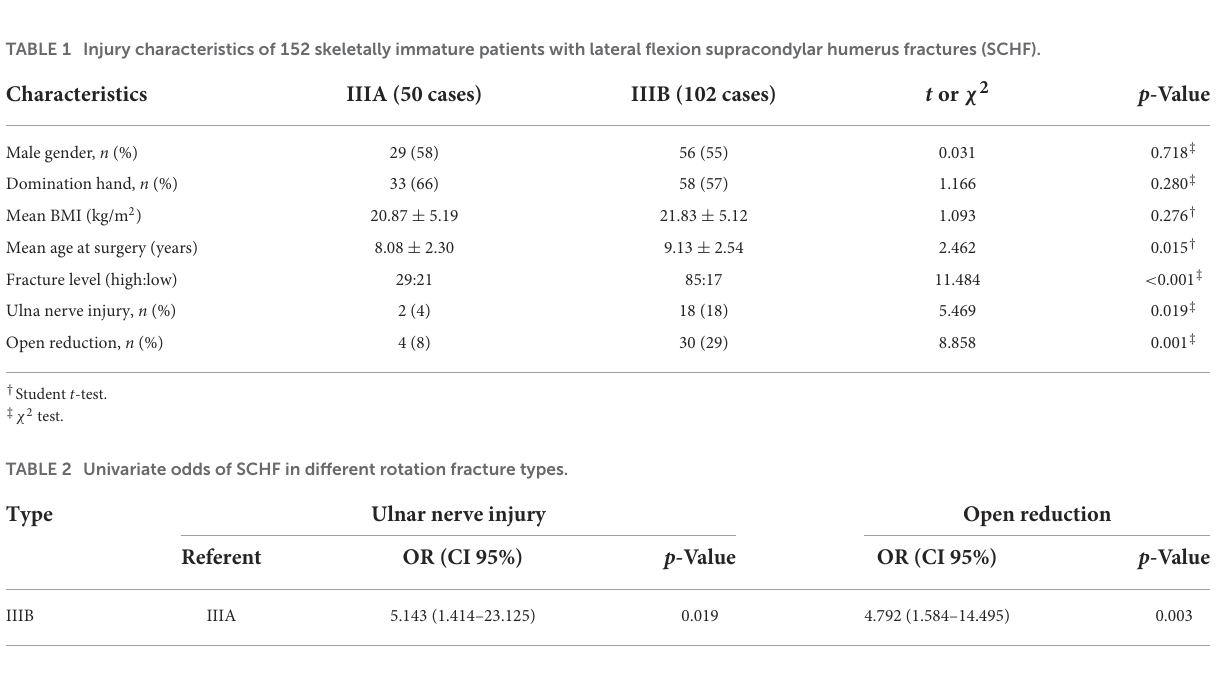
TABLE 3 The results of multiple logistic regression analysis of risk factors associated with type IIIB